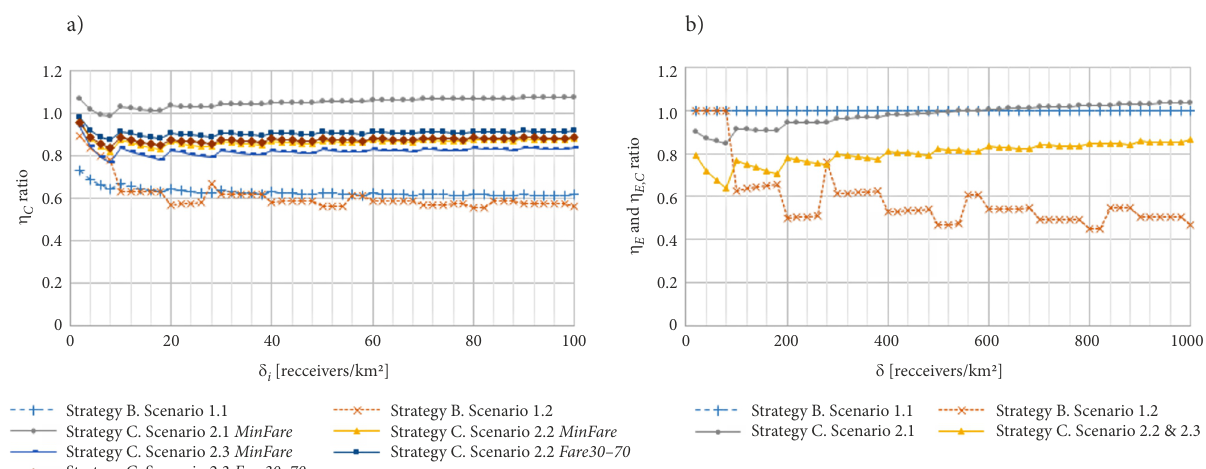
Figure 12. Results when all shipments are made by means of a collaborative strategy: a – h C ratio; b – h E or h E , C